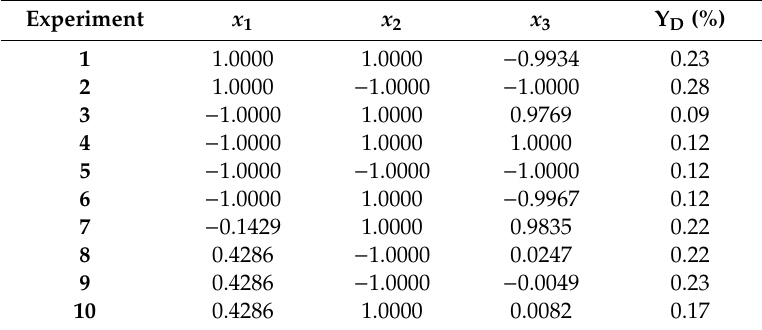
Table 6. Design yield (Y D ) for supercritical extraction of Pistacia lentiscus .